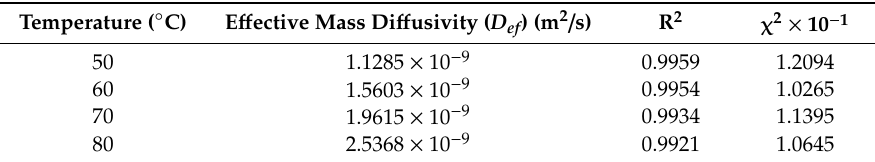
Table 2. E ff ective mass di ff usivity for model